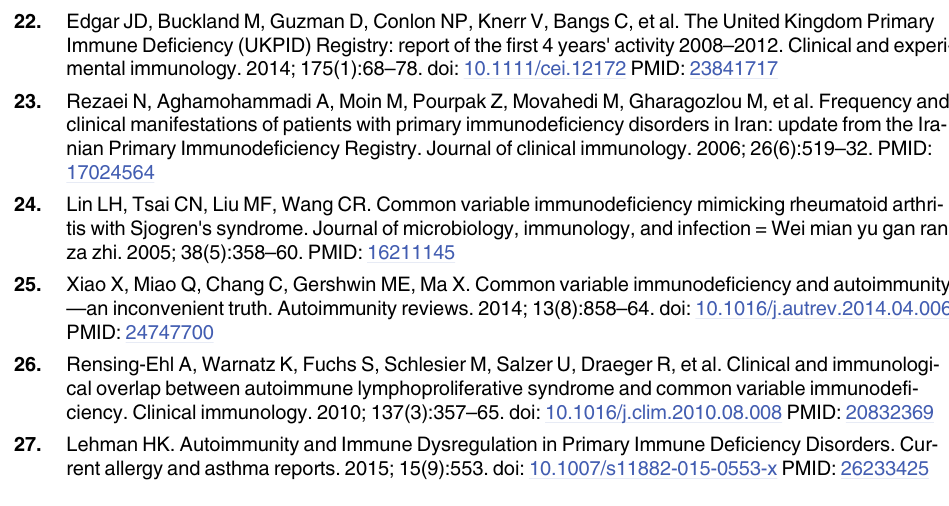
PLOS ONE | DOI:10.1371/journal.pone.0140473 October 13,